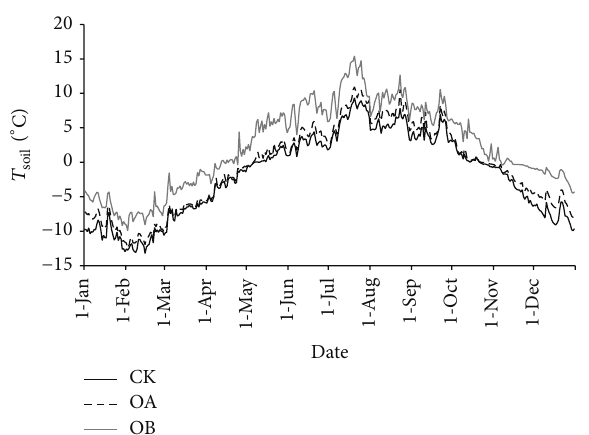
Figure 2: Seasonal variations in 5 cm depth soil temperature corresponding to the warming treatments.